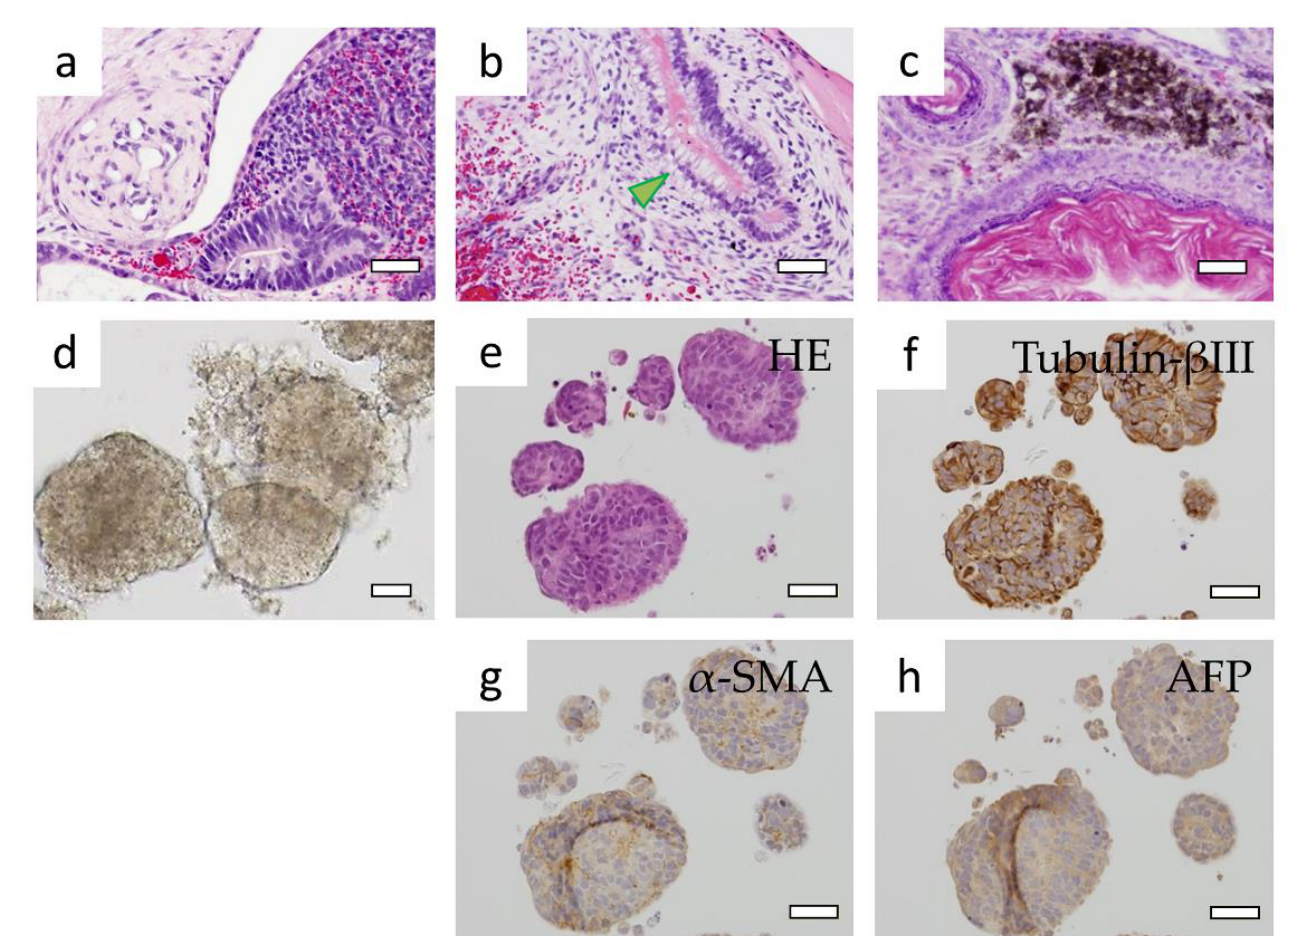
Figure 4. Observations of the formed teratomas and EBs. ( a – c ) The gastrointestinal tract ( arrowhead ), skin, and cells that produce melanin were mixed in the HE-stained sections of teratomas. ( d ) Morphology of suspension-cultured EBs. EB section specimens stained with ( e ) HE, ( f ) Tubulin-βIII, ( g ) α-SMA, and ( h ) AFP. Bars: 50 μm.